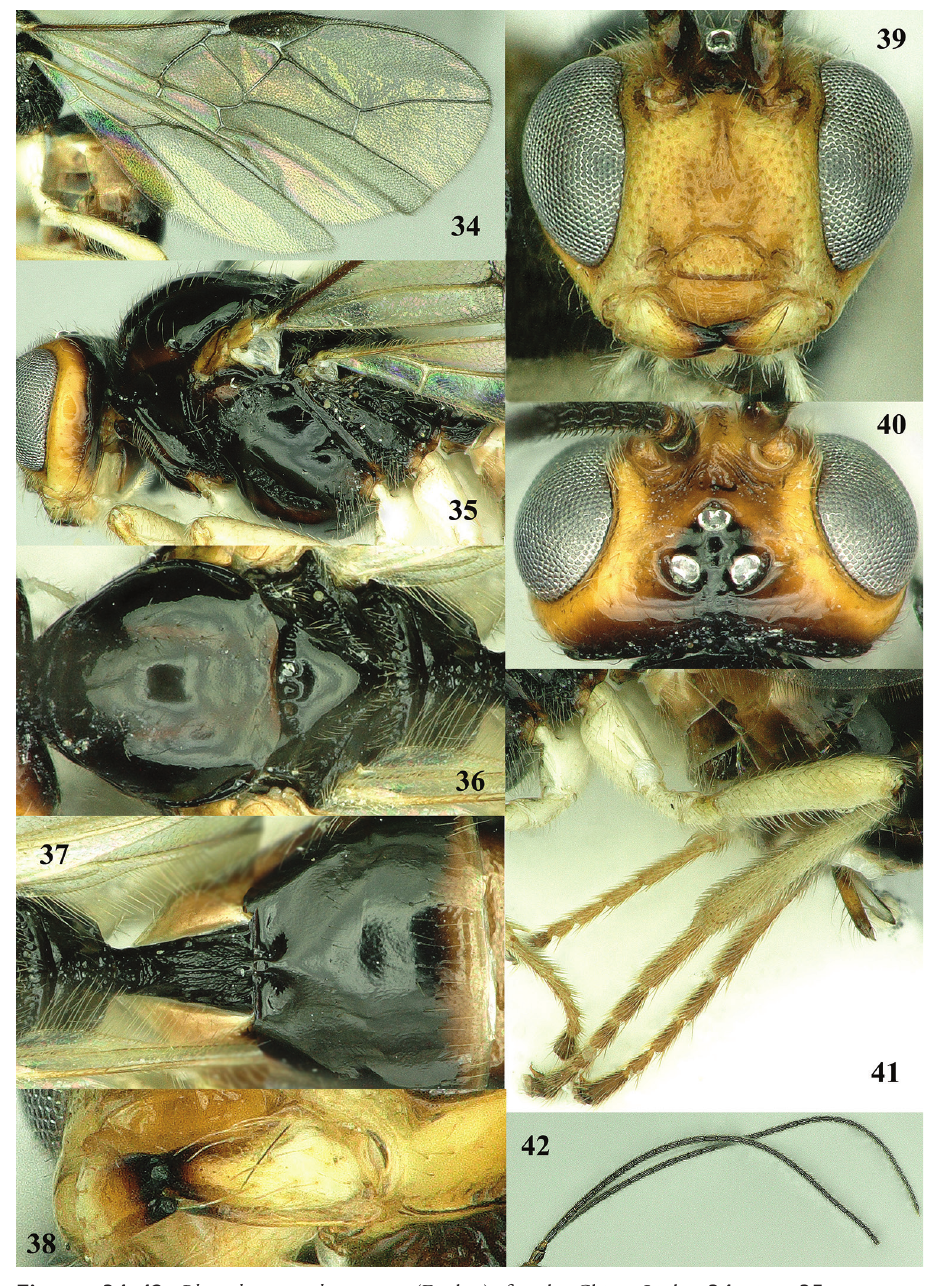
Figures 34–42. Rhogadopsis mediocarinata (Fischer), female, China, Liuba. 34 wings 35 mesosoma lateral 36 mesosoma dorsal 37 first-third metasomal tergites dorsal 38 mandible lateral 39 head anterior 40 head dorsal 41 hind leg 42